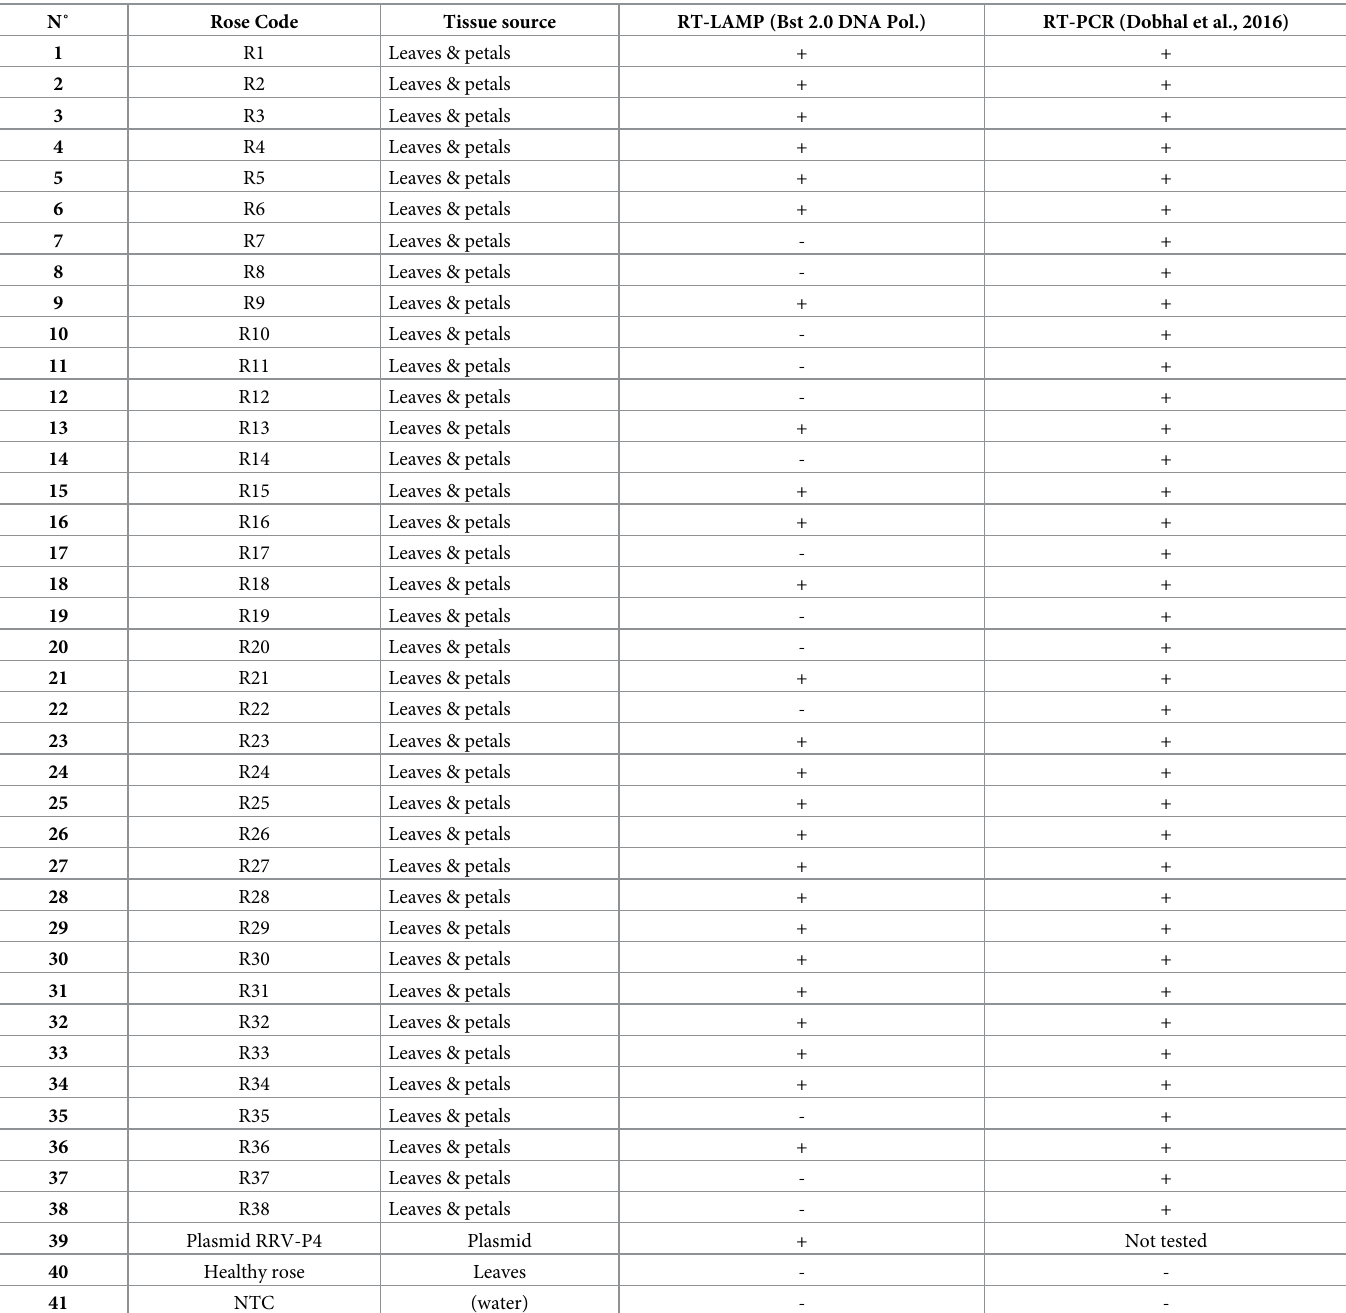
Table 2. Side-by-side comparison of RRV-P4 RT-LAMP made with Bst 2.0 DNA polymerase and RT-PCR. N˚ Rose Code Tissue source RT-LAMP (Bst 2.0 DNA